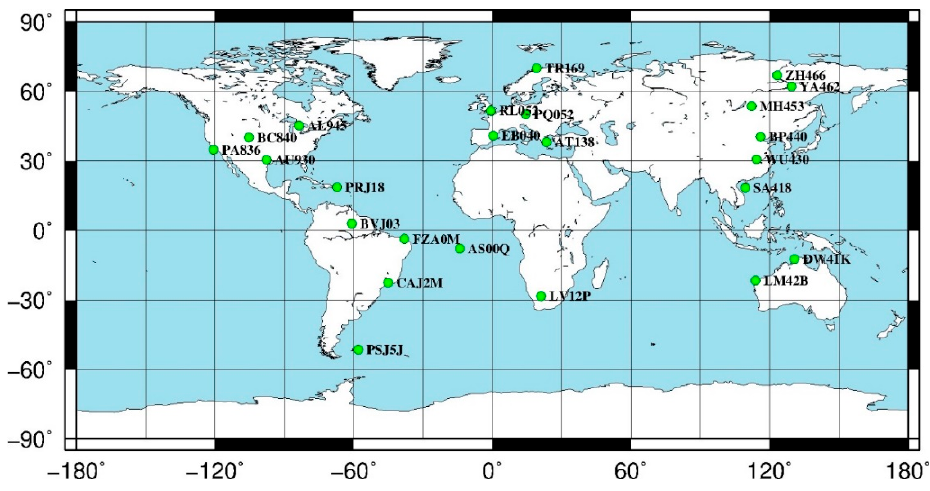
Figure 4. The distribution of the 24 digisonde stations .